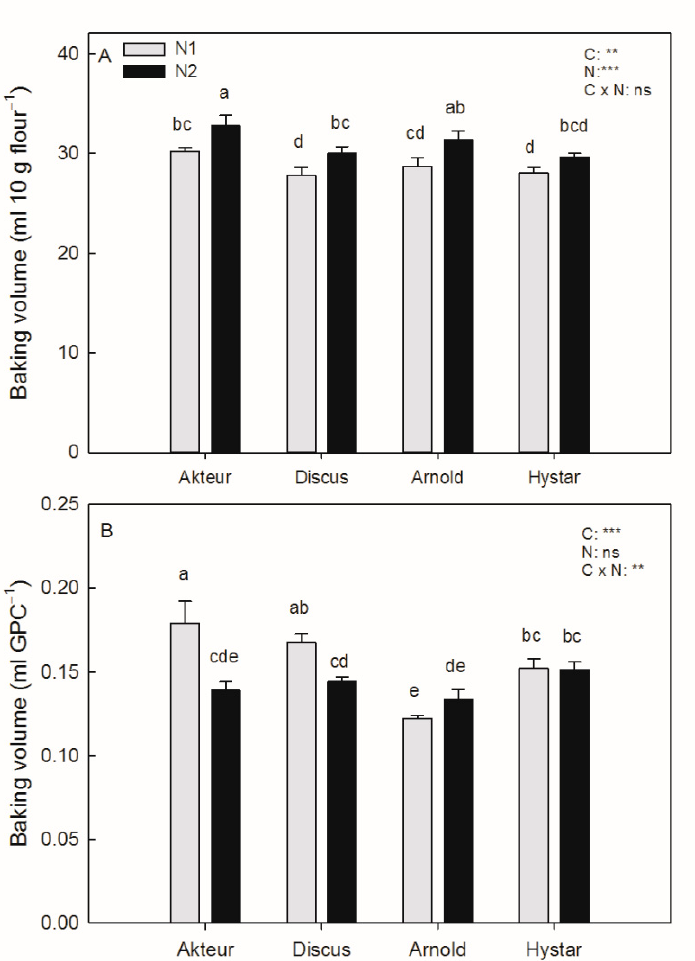
Figure 3. Effect of N2 and genotype on baking volume ( A ) and baking volume per GPC ( B ) (mean + S.E.M). The cultivar names are displayed on the x-axis. Different letters indicate significant differences ( p < 0.05). Two-way ANOVA results are given on the top right: **, p < 0.01; ***, p < 0.001; ns, not significant ( p ≥